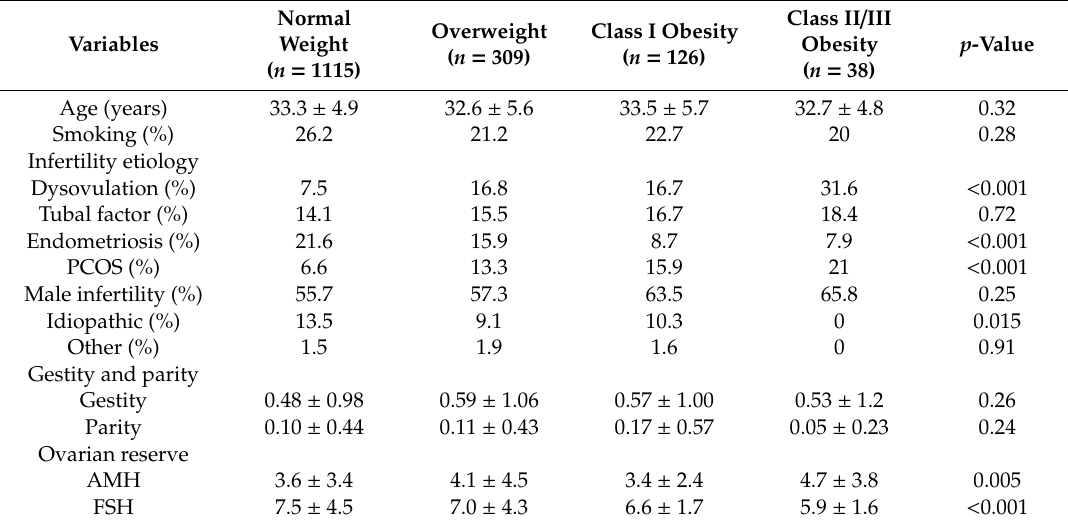
Figure 1. Flow chart. COS: controlled ovarian stimulation. Table 1. Characteristics of Women Included in the Study According to Their BMI